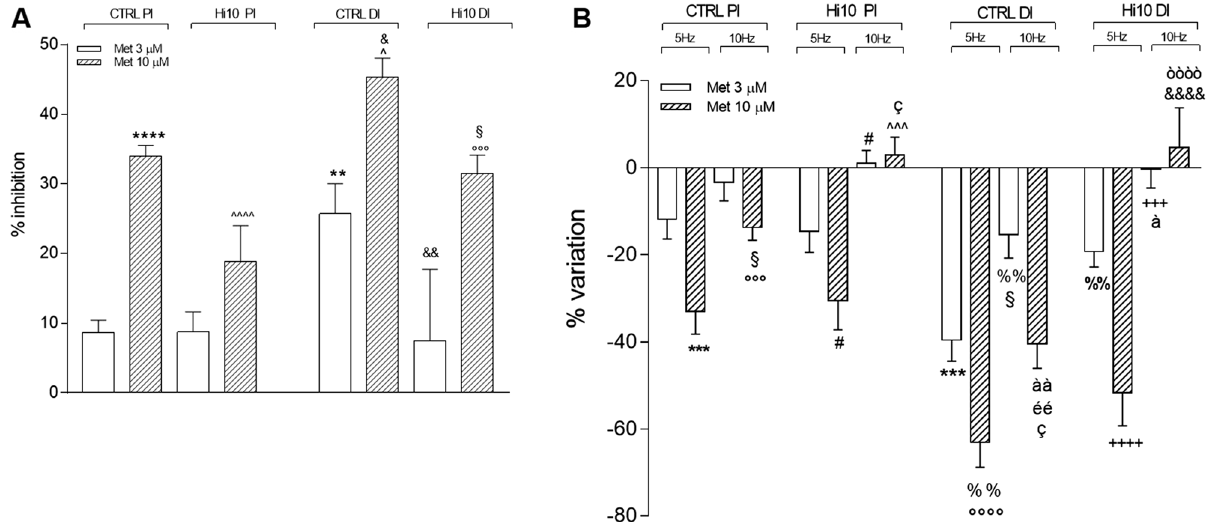
Figure 6. Hermetia illucens meal influences serotoninergic excitatory contractions in the proximal and distal intestine of the gilthead sea bream. ( A ) Inhibitory effect of the 5-HT antagonist, methysergide (3, empty bars, and 10 µM, dark upward diagonal bars) on spontaneous motor activity ( B ) and on NANC evoked contractions at 5 HZ and 10 Hz in the different experimental groups. Data are reported as mean ± SEM with N = 5 fish/ group. ( A ) Statistical significance: **** P < 0.0001 and ** P < 0.01 versus CTRL PI Met 3 µM; ^^^^ P < 0.0001, ^ P < 0.05 versus CTRL PI Met 10 µM; && P < 0.001 and & P < 0.05 versus CTRL DI Met 3 µM; °°° P < 0.001 versus Hi10 PI Met 10 µM; § P < 0.05 versus Hi10 DI Met 10 µM, by one-way ANOVA with Sidak’s post hoc test. ( B ) Statistical significance: *** P < 0.001 versus CTRL PI (5 Hz, Met 3 µM); °°°° P < 0.0001°°° P < 0.001 versus CTRL PI Met (5 Hz, 10 µM); § P < 0.05 versus CTRL PI (10 Hz; Met 3 µM); ç P < 0.05 versus CTRL PI (10 Hz Met 10 µM); # P < 0.05 versus Hi10 PI (5 Hz; Met 3 µM); ^^^ P < 0.001, ^ P < 0.05 versus Hi10 PI (5 Hz Met 10 µM); %% P < 0.01 versus CTRL DI (5 Hz, Met 3 µM); éé P < 0.01 versus CTRL DI (5 Hz, Met 10 µM); à P < 0.05 and ààà P < 0.001 CTRL DI (10 Hz, Met 3 µM); òòòò P < 0.0001 versus CTRL DI (10 Hz, Met 10 µM); &&&& P < 0.0001 versus Hi10 DI (10 Hz, Met 10 µM);). +++ P < 0.001 AND ++++ P < 0.0001 versus Hi10 DI (5 Hz; Met 3 µM), by one-way ANOVA with Sidak’s post hoc